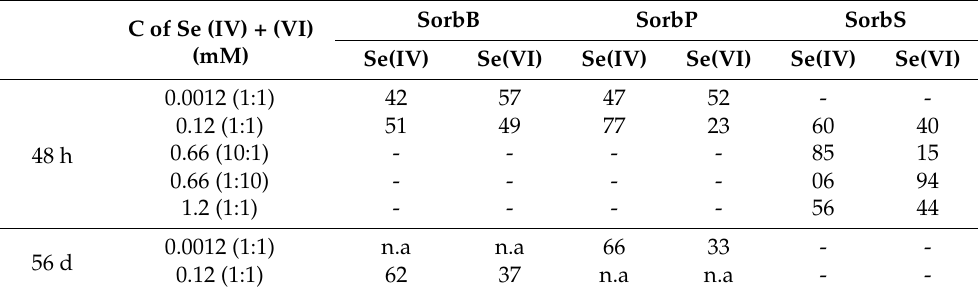
Table 4. LCF analysis for Se(IV) and Se(VI) in mixture adsorbed on SorbB, SorbP and SorbS (1 g/L) at initial Se concentration of 0.0012, 0.12, 0.66 and 1.2 mM at pH 3 after 48 h and 56 d. SorbB SorbP SorbS C of Se (IV) + (VI) (mM) Se(IV)